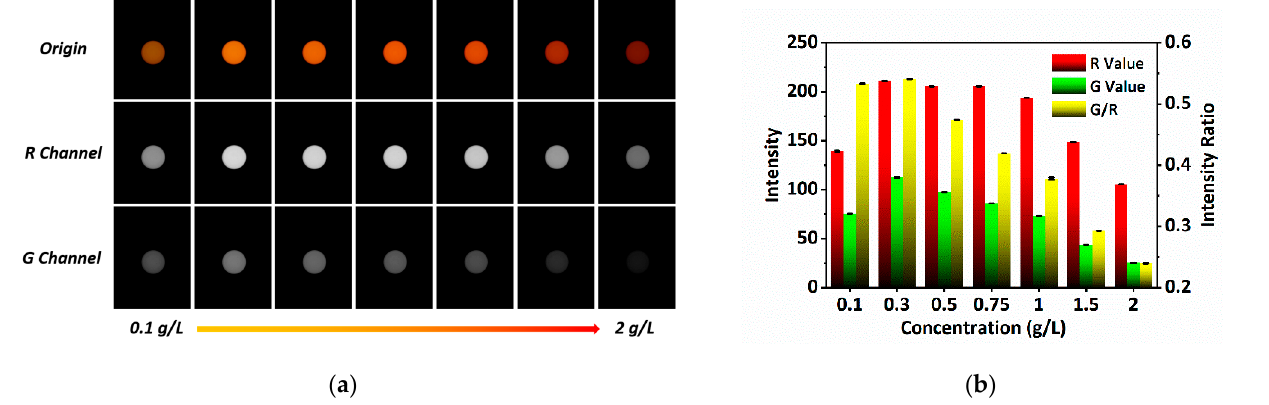
Figure 4. Sensing probe optimization. ( a ) Fluorescence images of sensing probes with different RhB concentrations; ( b ) R value, G value and G/R of sensing probes with different RhB concentrations.